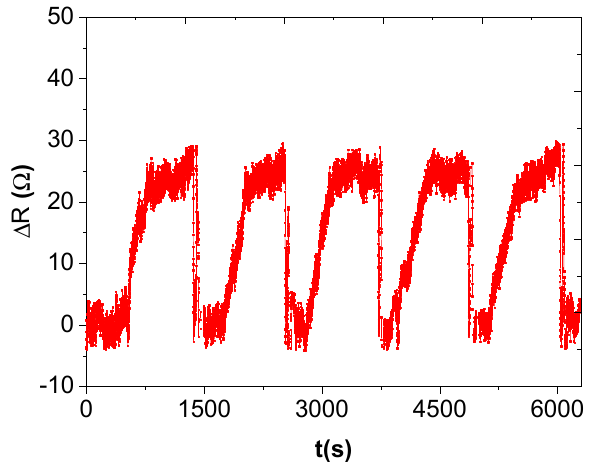
Figure 15. Repeatability graph of sensor 9 on mesitylene vapour.